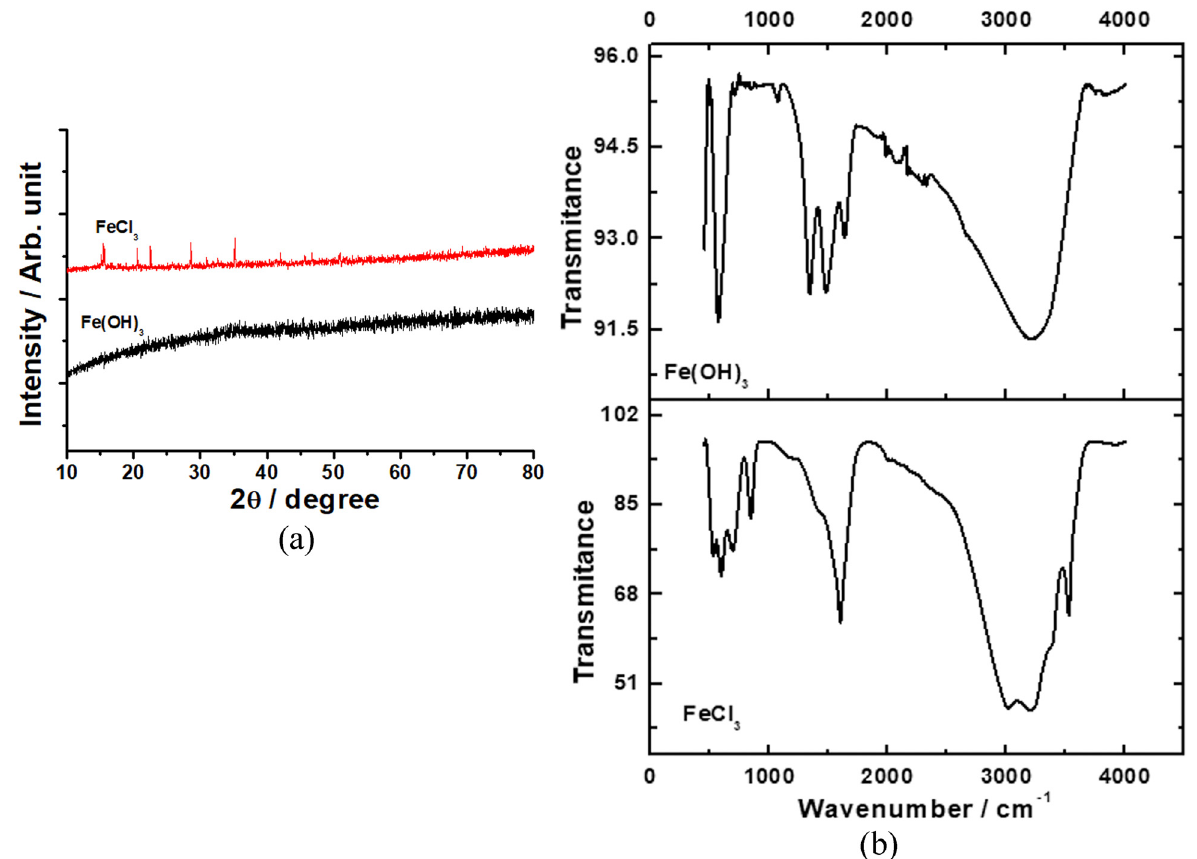
Figure 4: XRD ( a ) and FTIR spectra ( b ) of FeCl 3 and Fe ( OH ) 3